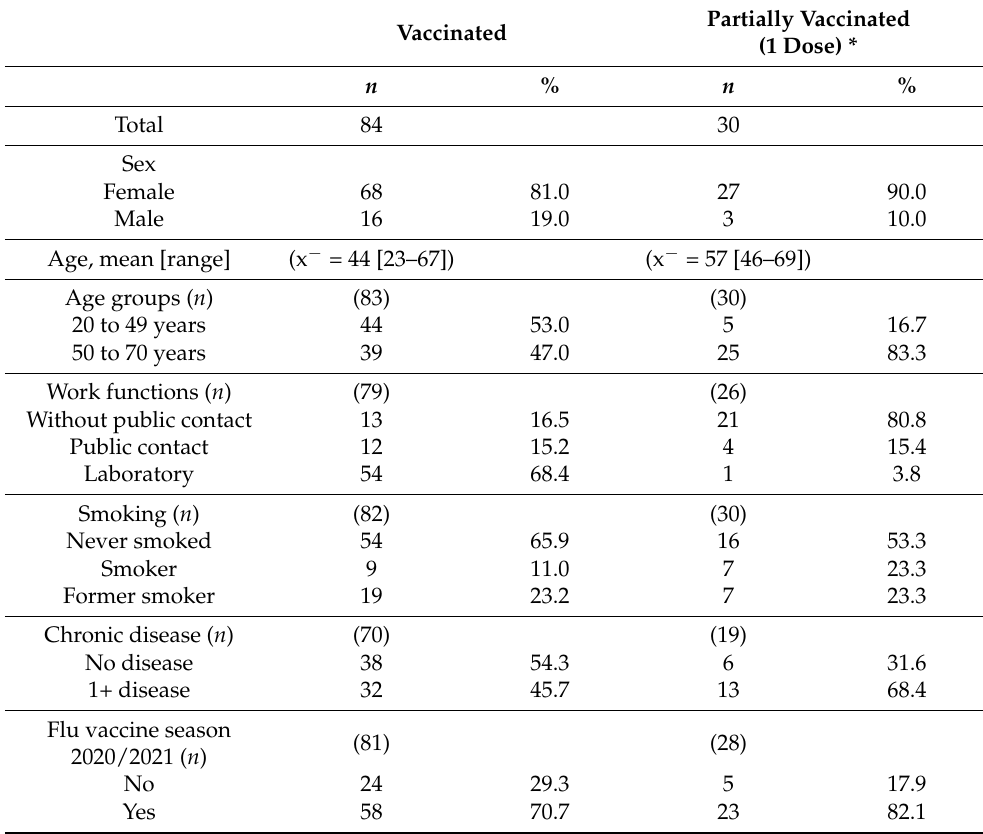
Table 1. Vaccinated and partially vaccinated participants’ sociodemographic, work, and health